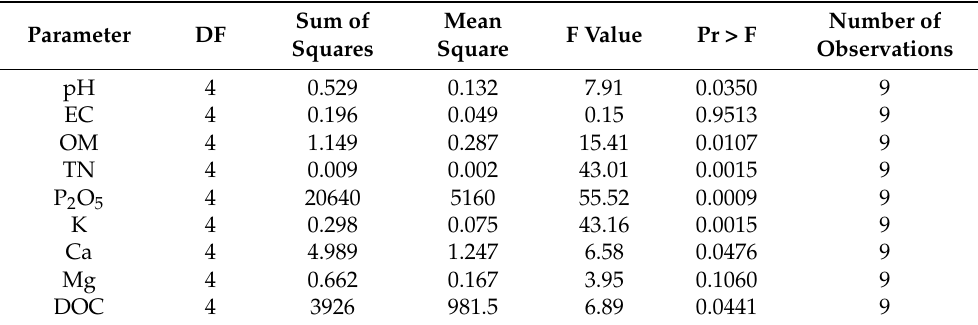
Table 1. ANOVA summary table for the soil chemical parameters in paddy fields under long-term compost fertilization.